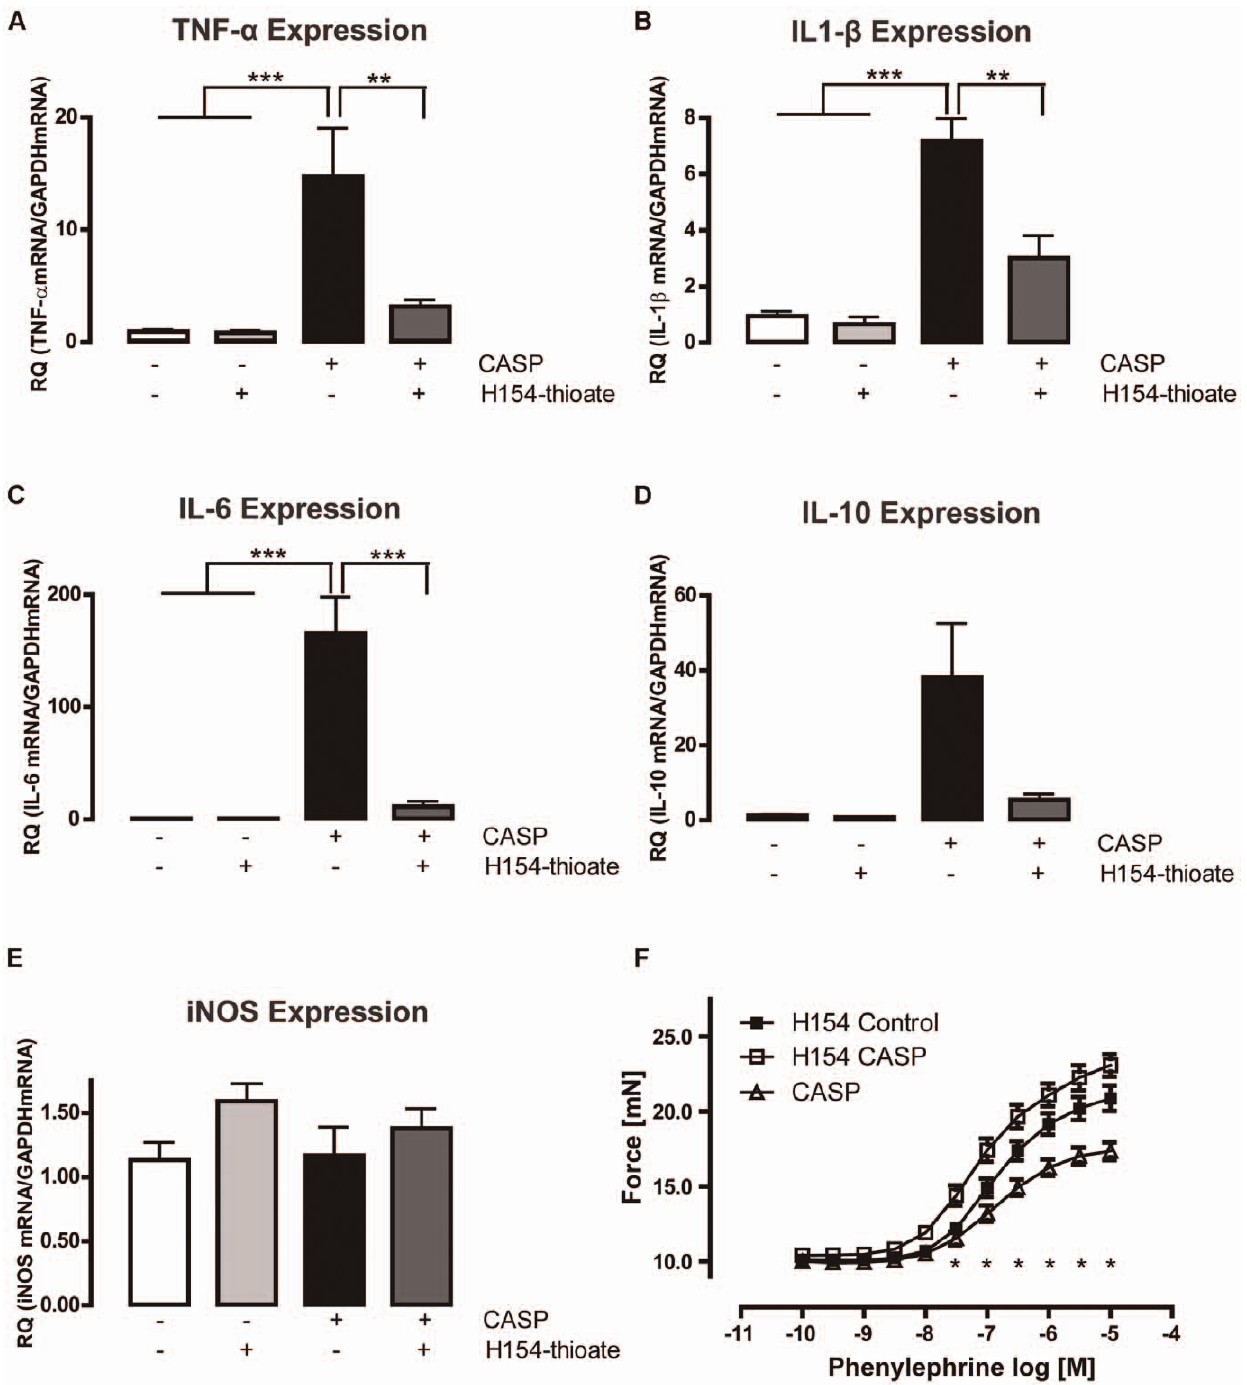
Figure 5. Prevention of CASP induced aortic cytokine and iNOS production following TLR9 antagonist treatment. A-E 24 h of exposure to the synthetic TLR9 antagonist H154-thioate did not induce mRNA expression of the investigated cytokines, but prevented the CASP- dependent rise in mRNA expression of inflammatory mediators. There was no observable influence of H154-thioate on iNOS expression. F H154- thioate treatment prior to CASP completely prevented the CASP-induced arterial hypocontractility observed in WT animals (F) (*p , 0.05; **p , 0.01; ***p , 0.001; n $ 5 animals in each group; mean 6 SEM).